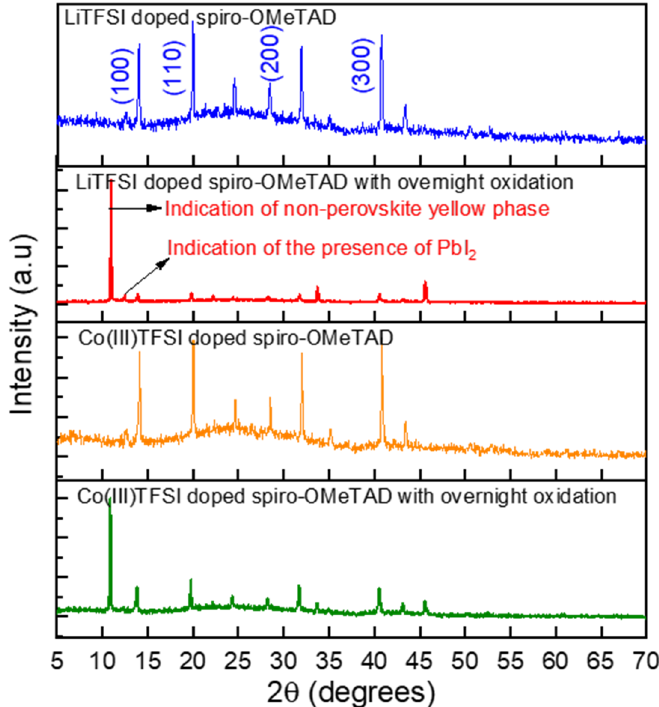
Figure 3. XRD patterns for perovskite/LiTFSI-doped spiro-OMeTAD and perovskite/Co(III)TFSI co-doped spiro-OMeTAD for different oxidation conditions.